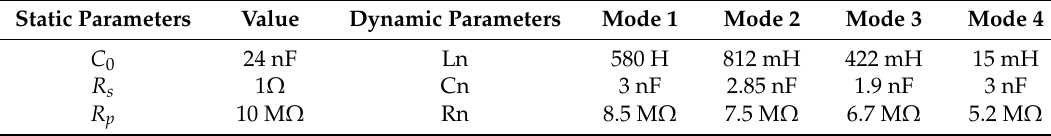
Table 1. Equivalent parameters of the bimorph actuator.